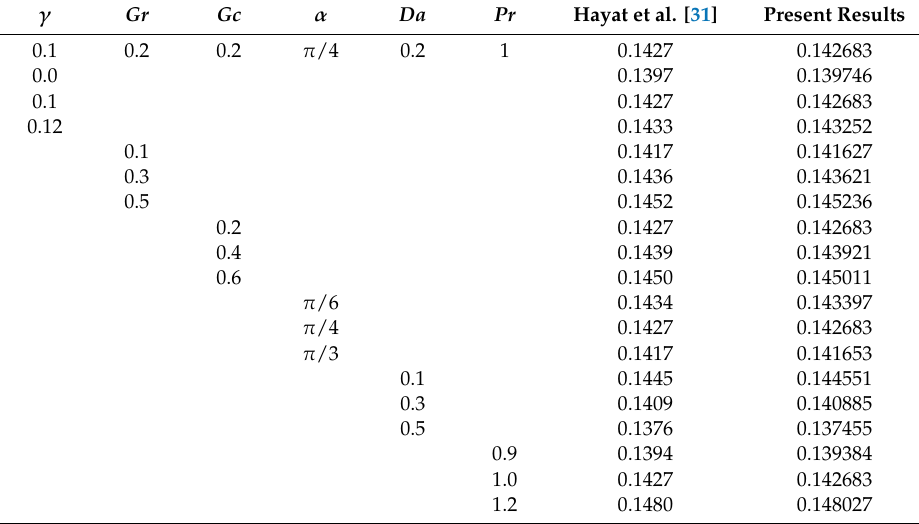
Figure 9. 𝜙(𝜂) for different 𝑆𝑟 and 𝐷𝑢. Figure 9. φ ( η ) for di ff erent Sr and Du . Table 1. Variation in the local Nusselt number Nu x / Re 1/2 x for various parameters.